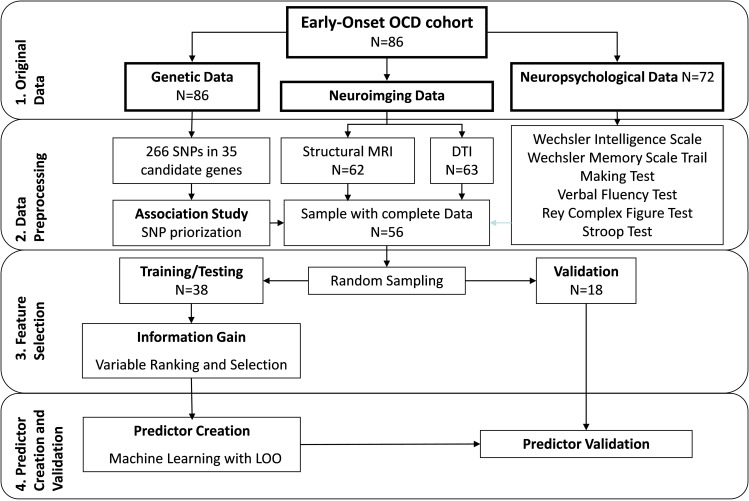
The data analysis workflow used in the present study.OCD, obsessive-compulsive disorder; MRI, magnetic resonance imaging; DTI, diffusion tensor imaging; SNP, single nucleotide polymorphism; CV, cross-validation.